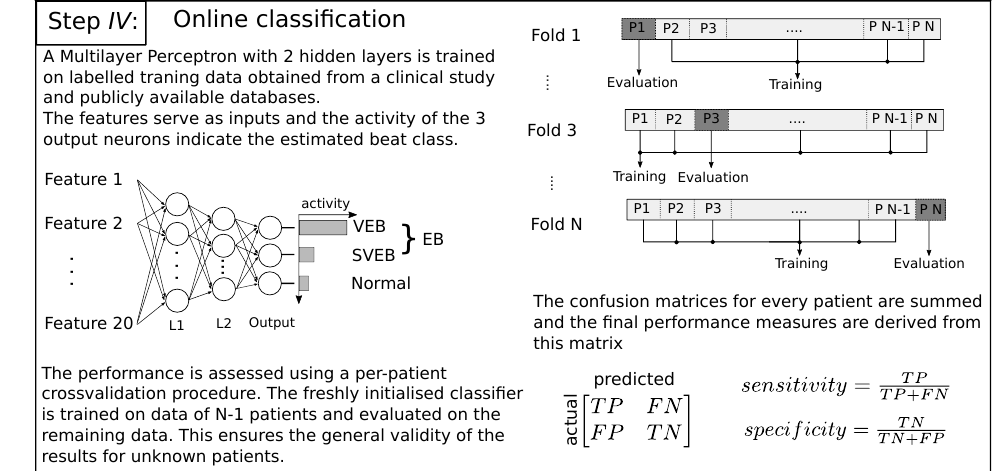
Figure 3. Overview on the proposed multimodal ectopic beat detection